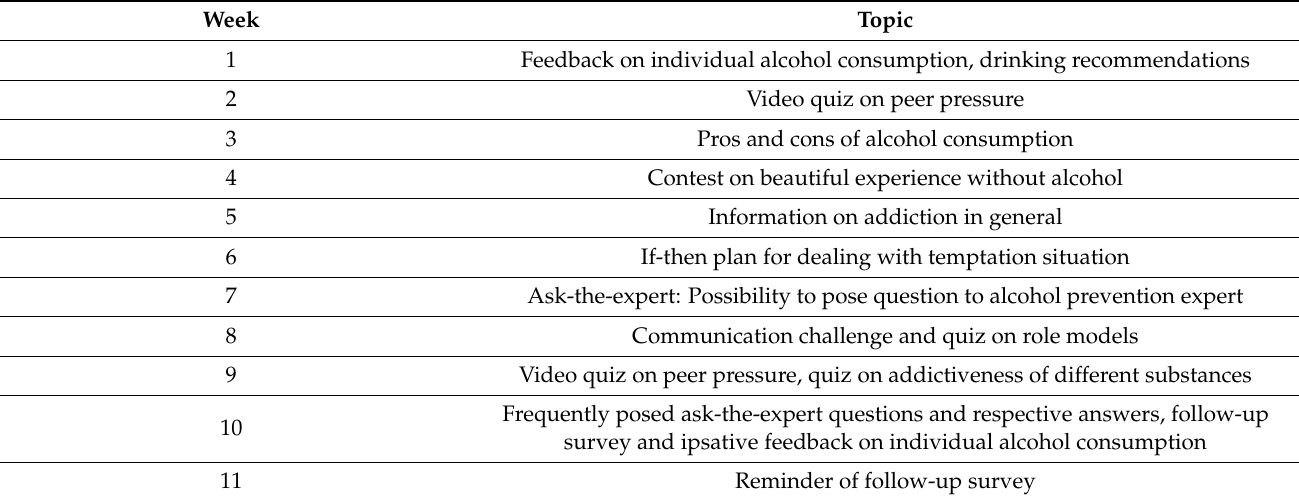
Table 1. Content of the weekly coaching in the MobileCoach Alcohol